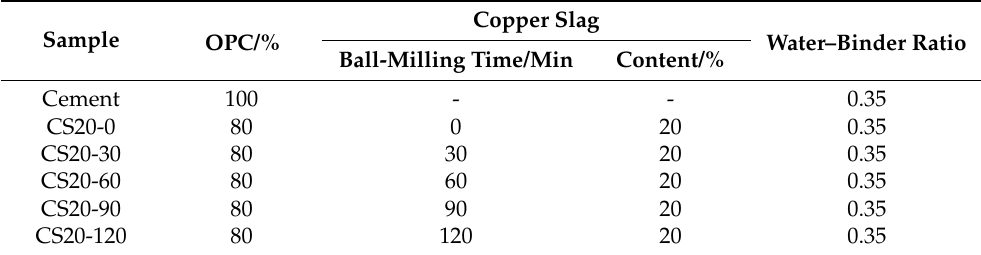
Table 2. Mixing ratio of copper slag powder-based composite cementitious system with different grinding